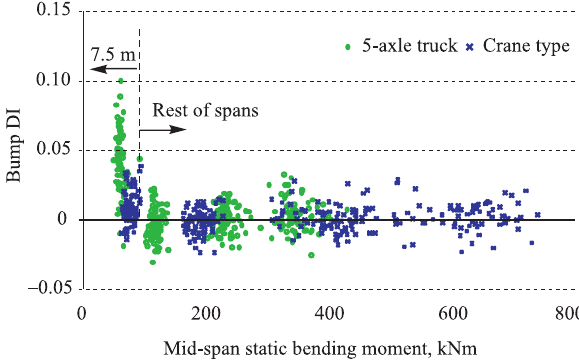
Fig. 8. Bump dynamic increment for vehicles on class B